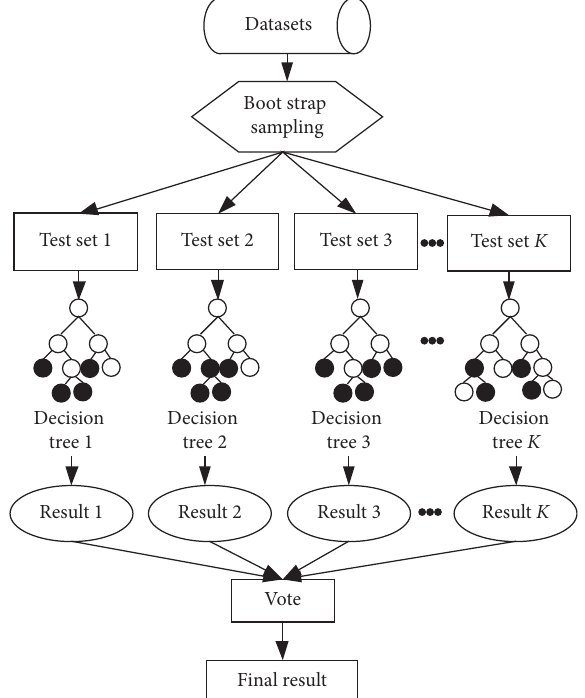
Figure 1: Schematic diagram of the random forest